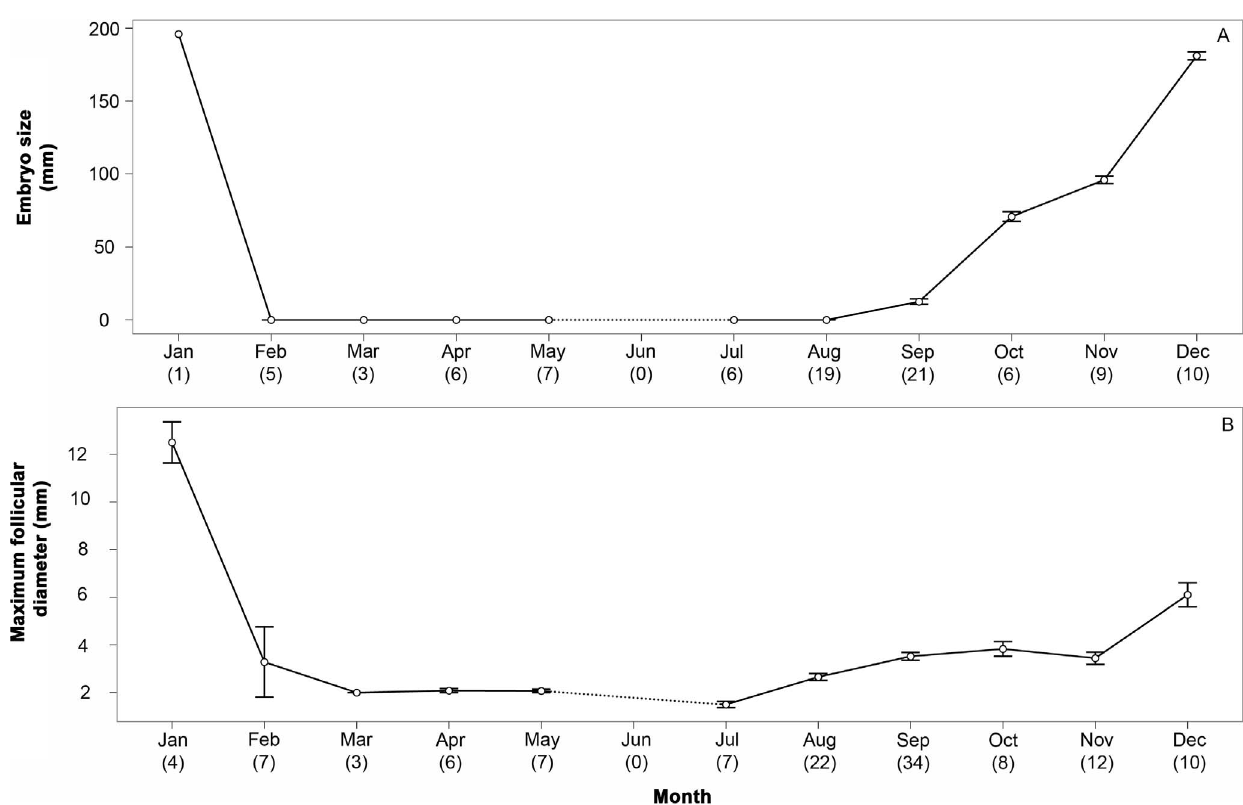
Figure 1. Average monthly size ( ± SE) of (A) embryos and (B) maximum ovarian follicles in Rhizoprionodontaylori . Numbers in brackets denote sample size.